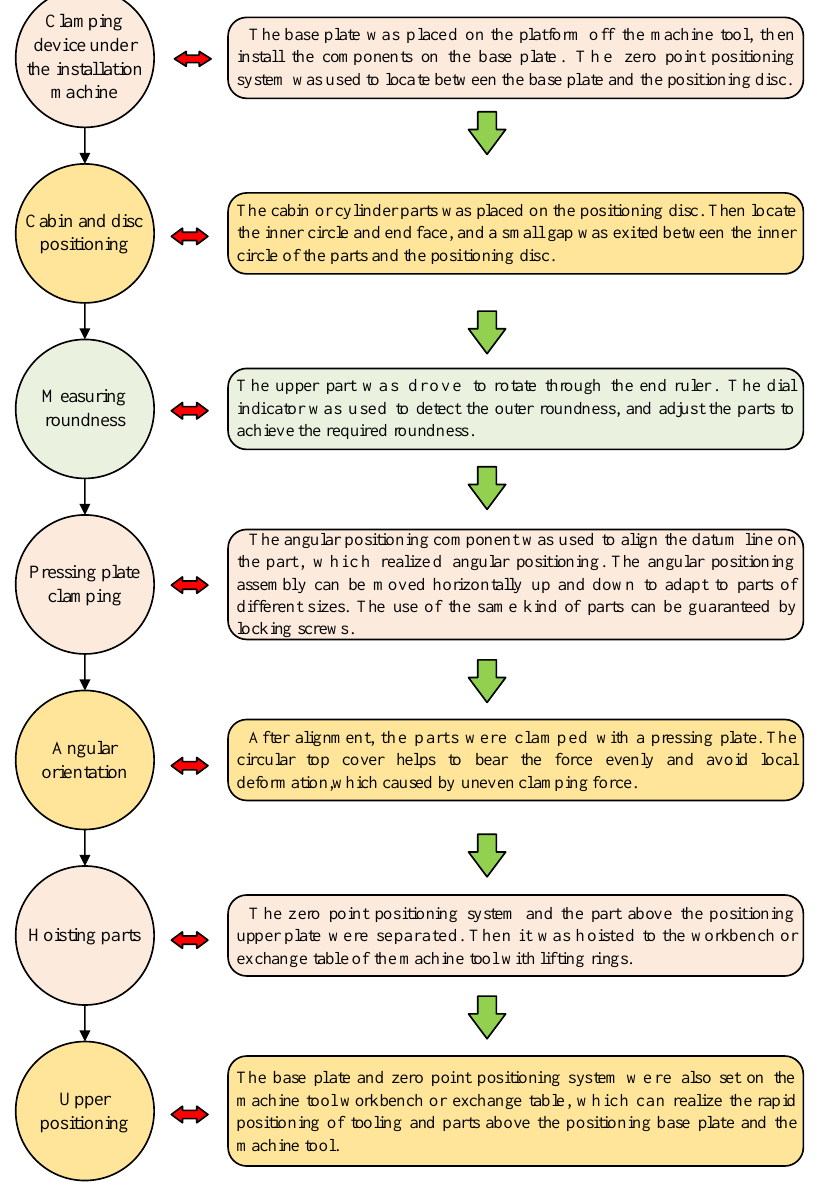
Figure 13. Clamping and alignment operation flow chart.